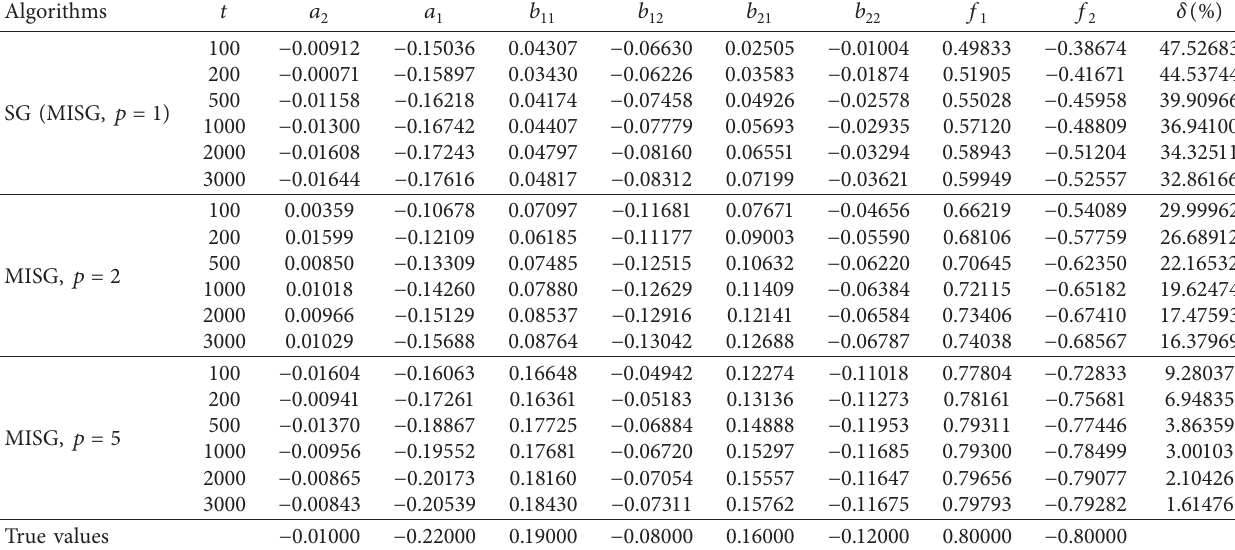
Table 4: The parameter estimates and errors with σ 2 � 0 . 30 2 .